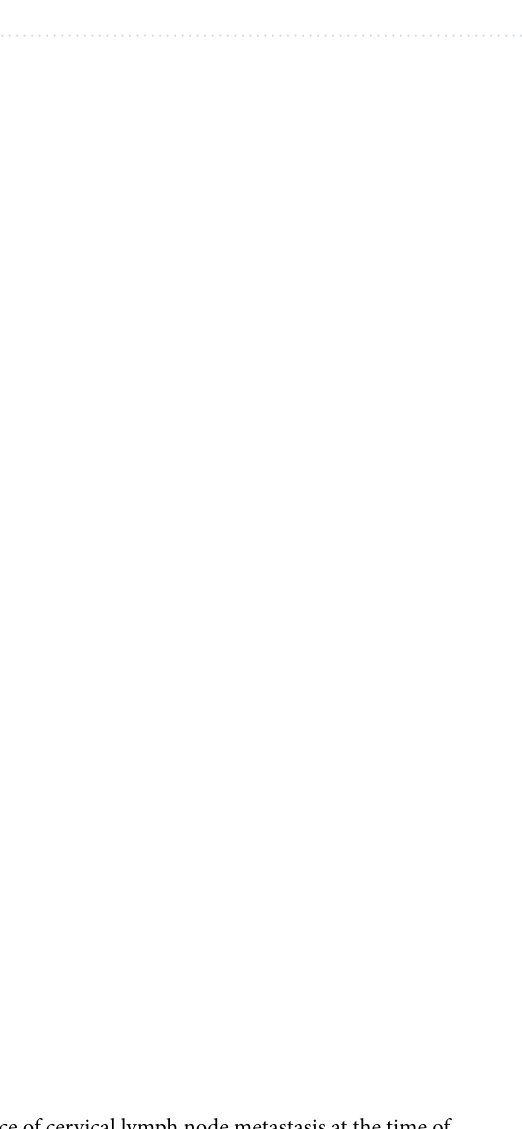
Table 1. Patient characteristics.